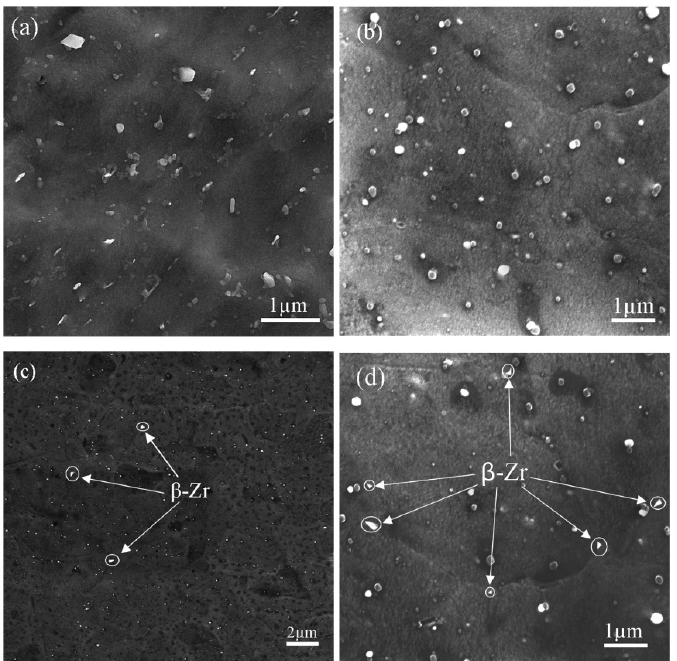
Figure 5. FEG-SEM images of different quenched samples: ( a ) at 705 °C ( b ) at 710 °C ( c ) at 715 °C ( d ) at 720 °C.